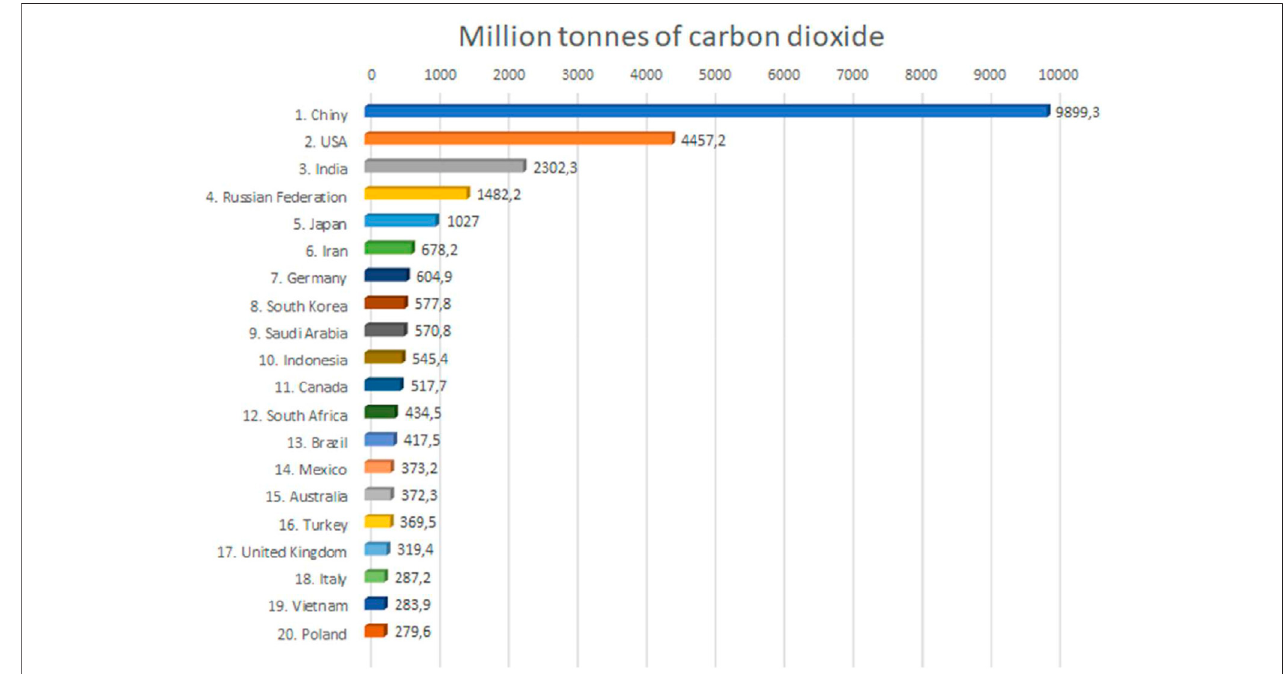
FIGURE 2 | Carbon dioxide emissions in 2021 - largest CO 2 emitters in the world. According to Statistical Review of World Energy 2021/70th edition. Available online: https://www.bp.com/content/dam/bp/business-sites/en/global/corporate/pdfs/energy-economics/statistical-review/bp-stats-review-2021-co2-emissions.pdf (accessed on: August 24,